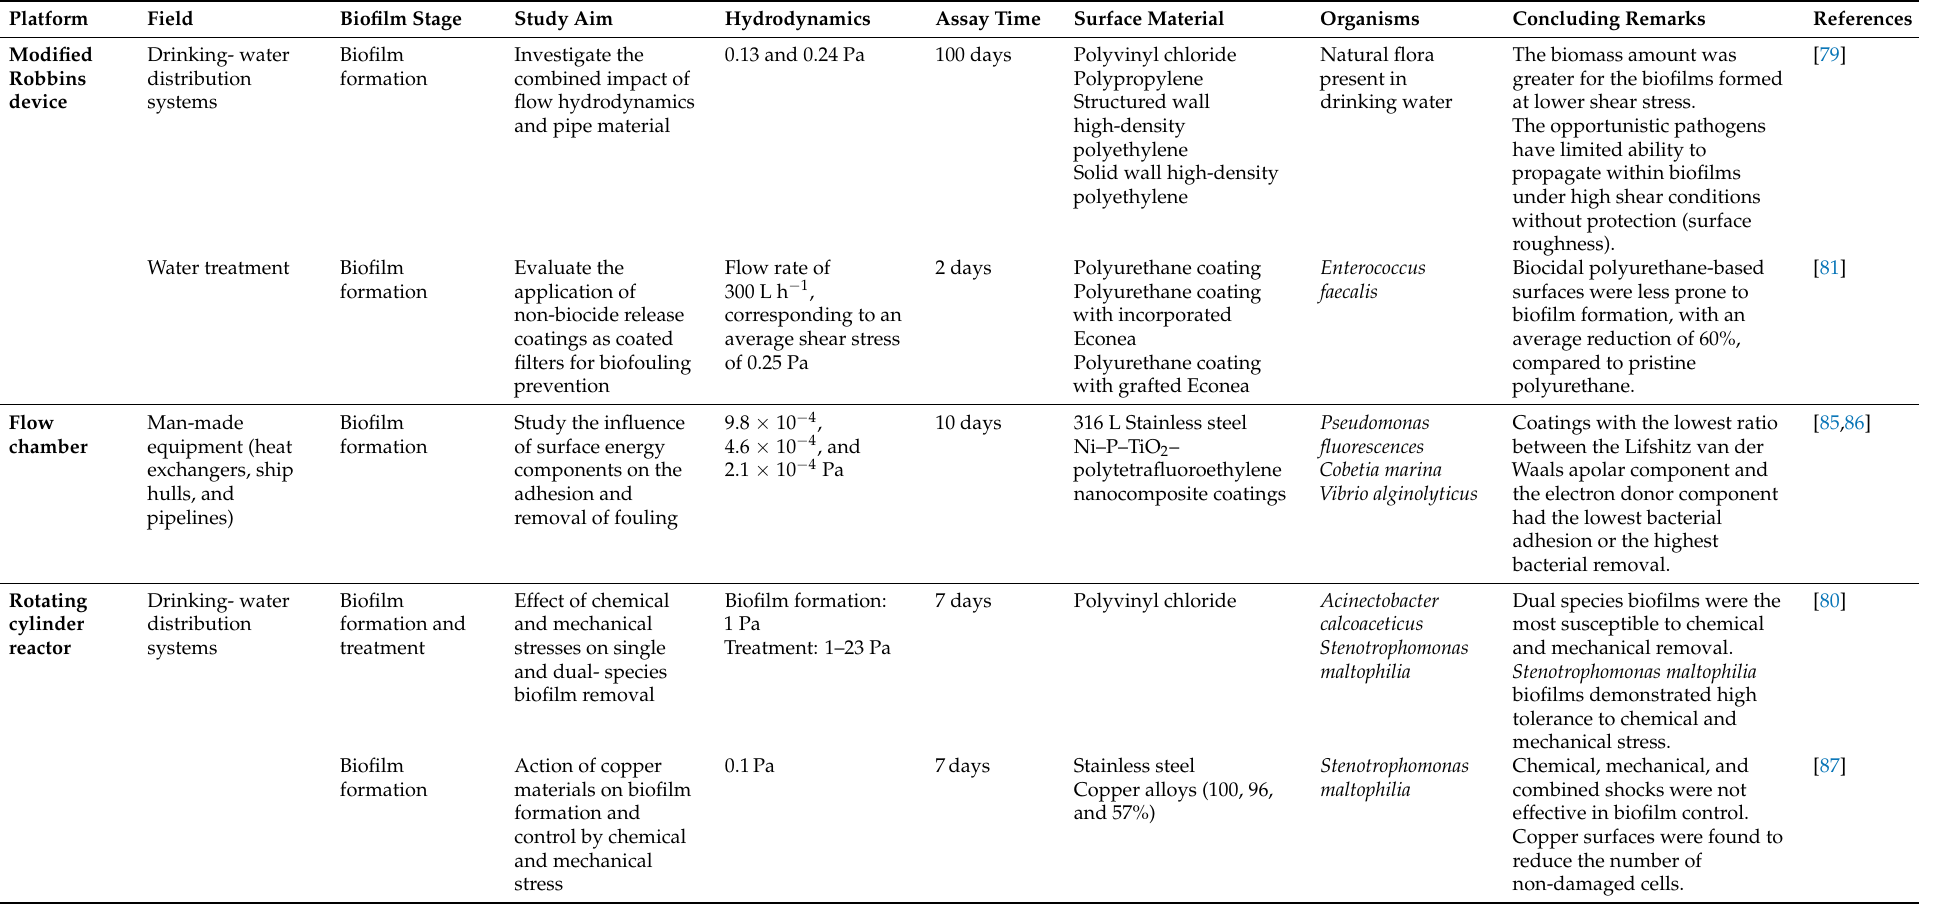
Table 3. Environmental studies performed on different biofilm platforms to evaluate the initial adhesion, biofilm formation, and treatment under defined shear